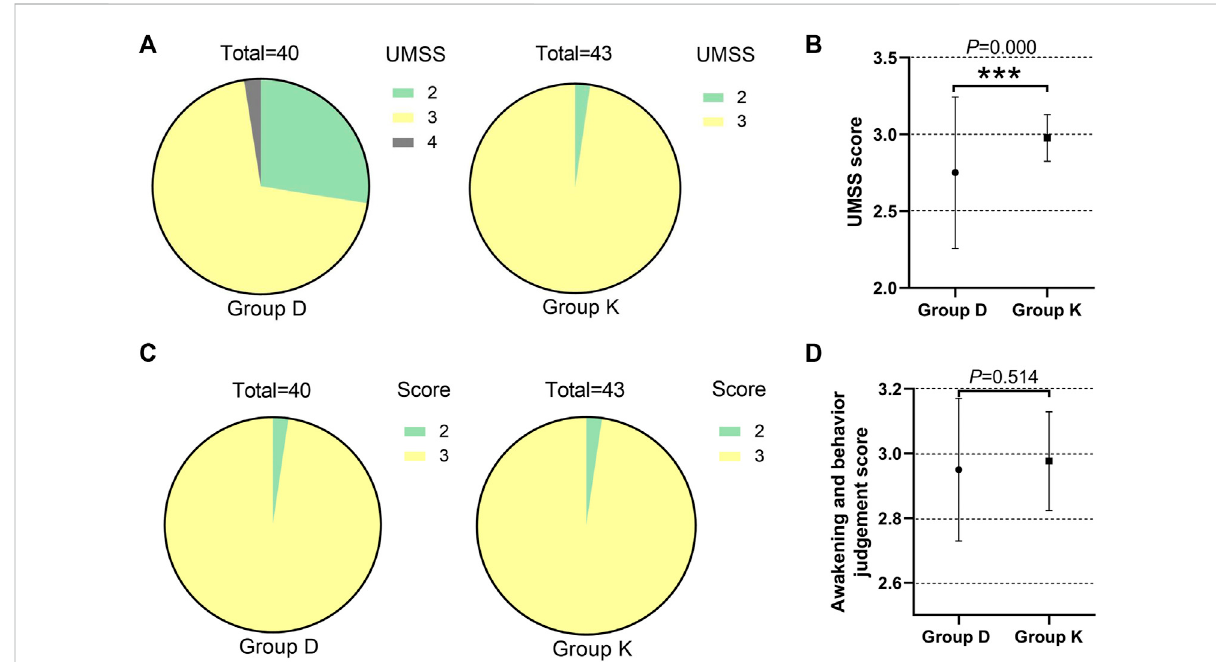
FIGURE 3 Different effects of two groups during drug-induced sleep endoscopy in children with obstructive sleep apnea hypopnea syndrome. (A) The number of subjects with each UMSS score in two groups. (B) UMSS score. (C) The number of subjects with each ABJ score in two groups. (D) ABJ score. Data are expressed as median (interquartile range) or frequency (%), Compare between two groups * p < 0.05, ** p < 0.01, *** p <